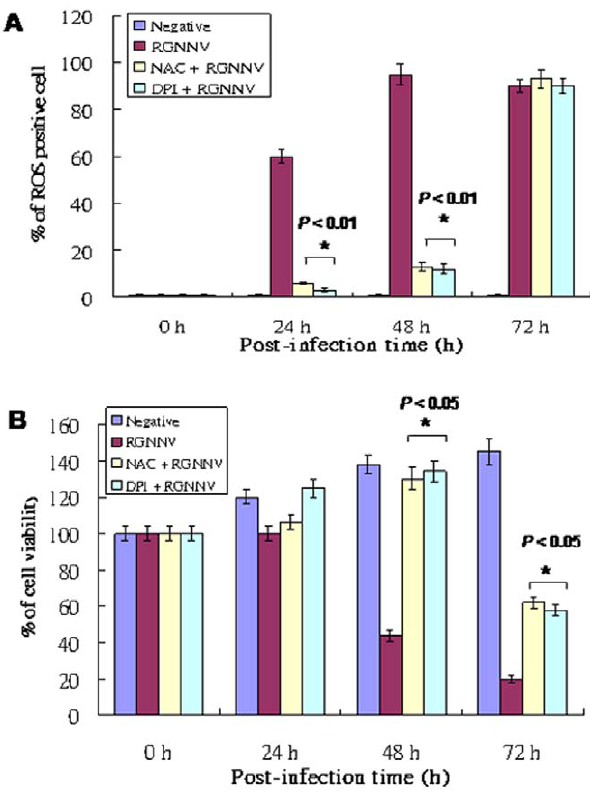
Figure 3. Influence of anti-oxidants NAC and DPI treatments on ROS production and cellular viability during RGNNV infection. (A) The GF-1 cells pre-treated with antioxidants either NAC or DPI for two hours, then infected with RGNNV (MOI=1) for different time incubations. The number of ROS producing cells infected with RGNNV TN1 at 0, 24, 48, and 72 h pi was assayed with the Image-iT LIVE Green Reactive Oxygen Species Detection Kit. Data are the percentage of 200 cells at each time point, determined in triplicate, with each point representing the mean of three independent experiments; error bars represent the SEM. The data were analyzed using either a paired or unpaired Student’s t -test. as appropriate. * P , 0.01. (B) The viability of GF-1 cells infected with RGNNV and treated with or without NAC or DPI at 0, 24, 48, and 72 h pi in triplicate by using a trypan blue dye exclusion assay [37]. The data were analyzed using either a paired or unpaired Student’s t -test. as appropriate. * P , 0.05.